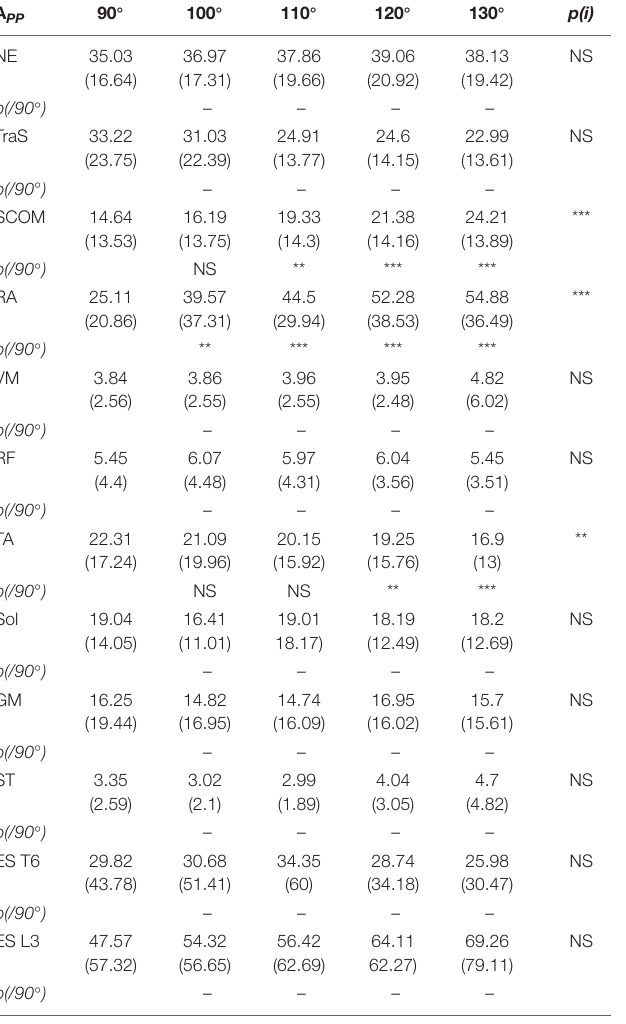
TABLE 2 | Mean (SD) muscle activity levels in the postural phase (A PP ), in % MVC, for the 5 inclination conditions, calculated for both execution speeds. A PP